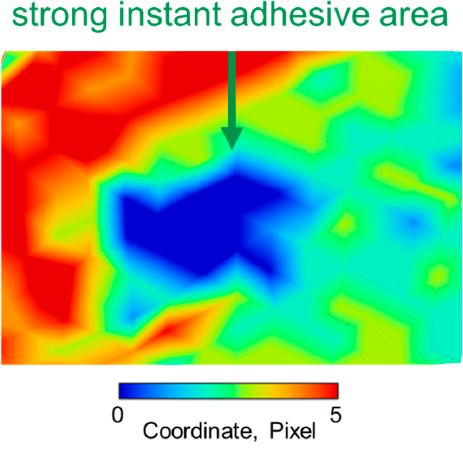
Figure 12. Displacement distribution region performed by SiDIC in the x-direction.